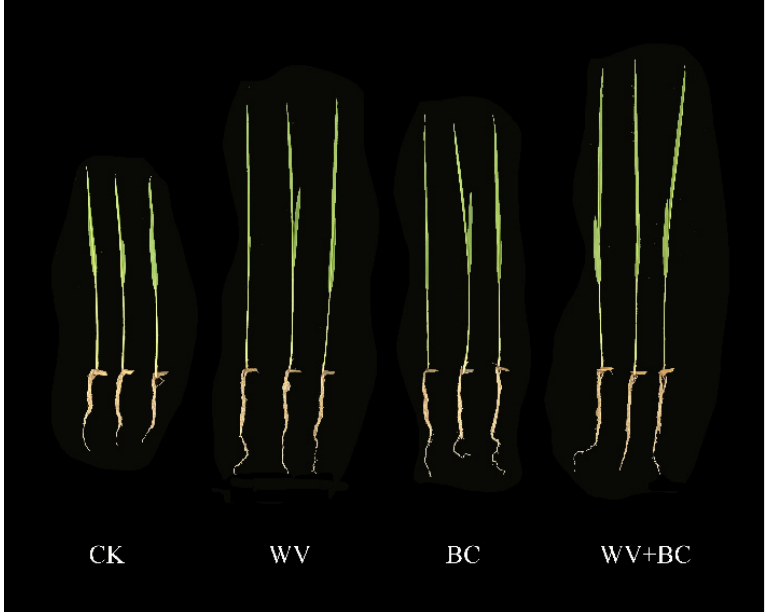
Figure 4. Pictorial illustration of different seed treated rice seedlings at 14 DAS under growth cham-